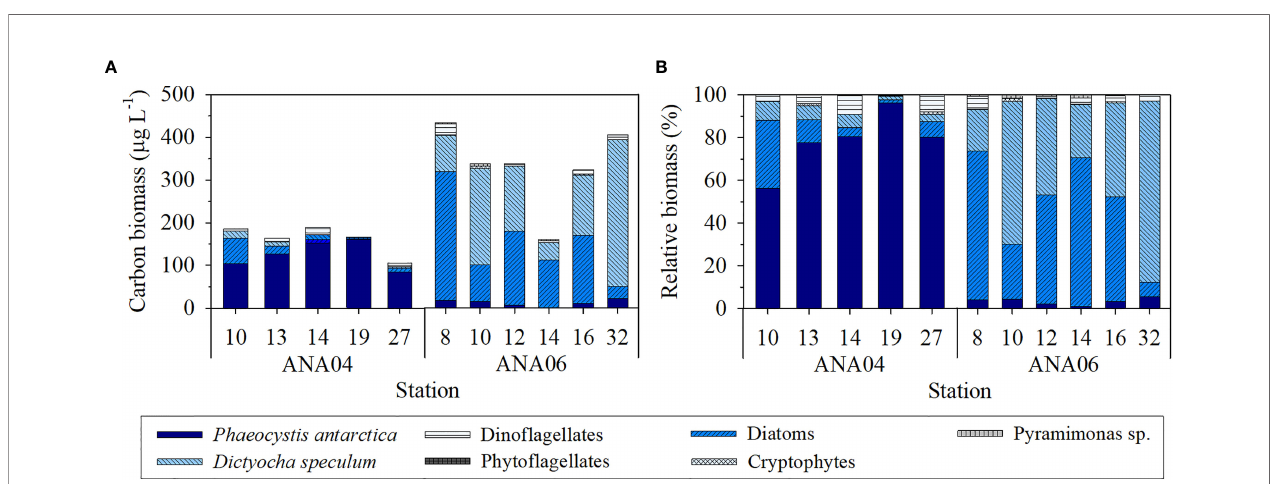
FIGURE 4 | Carbon biomass (A) and relative biomass (B) of the major phytoplankton groups in ANA04 and ANA06 (recalculated from Lee et al., 2016b; Lee et al.,